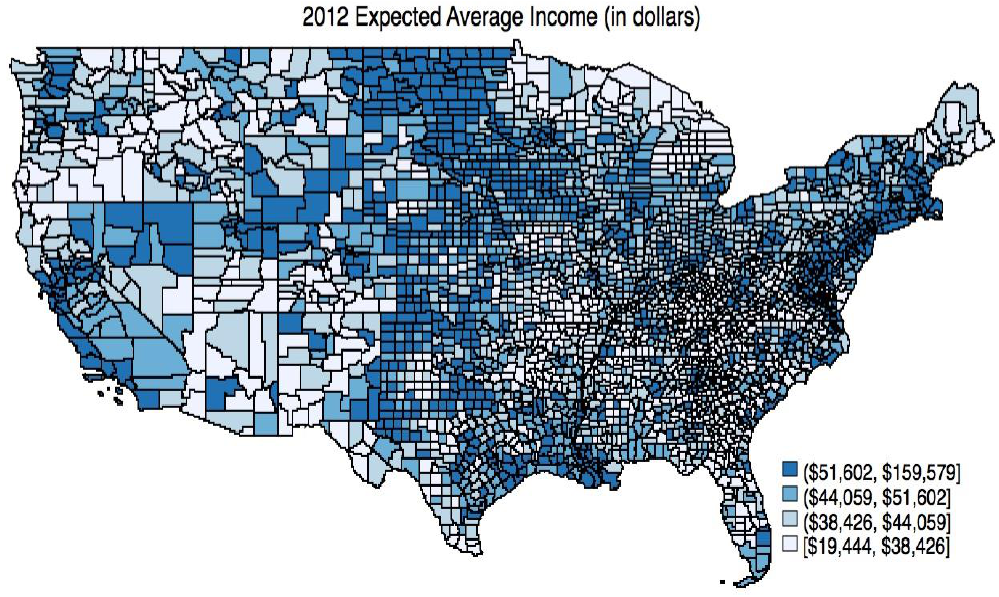
Figure 2. Expected average income for counties in the continental United States. Source: created by the authors using STATA software.